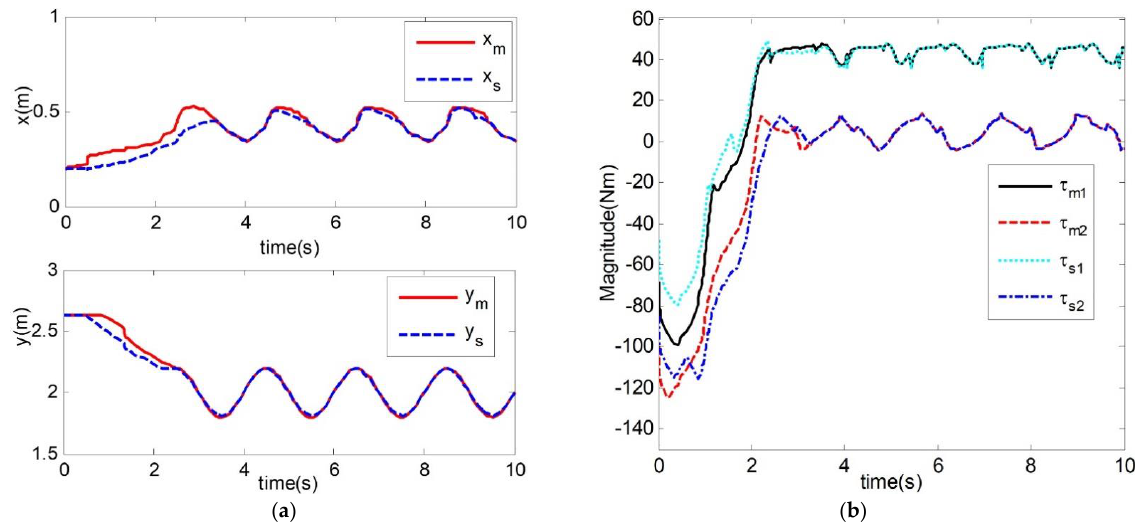
Figure 9. Simulation results. ( a ) Master and slave robot end position trajectory; ( b ) Master and slave robot joint input torque.